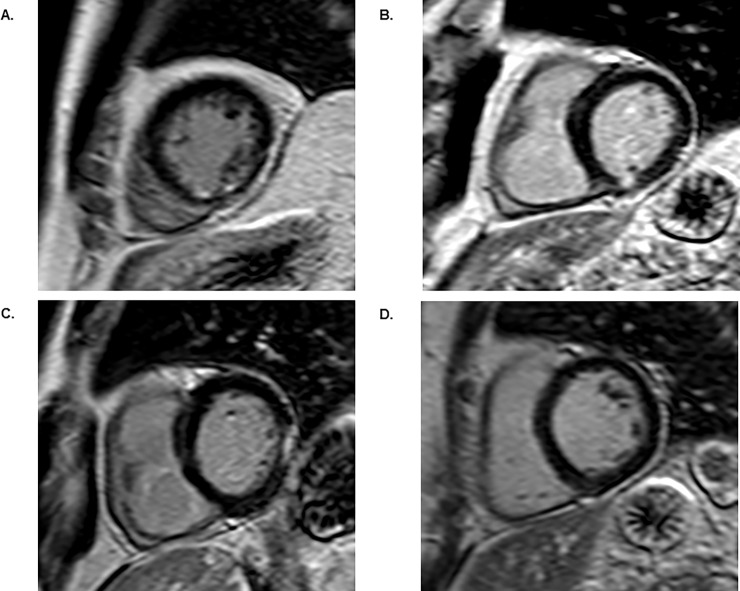
Examples of representative CMR-LGE images in patients with and without UMIs.a. subendocardial UMI, b. transmural UMI, c. area of LGE without a subendocardial component, i-e. no MI, d. no LGE, i.e. normal myocardium.